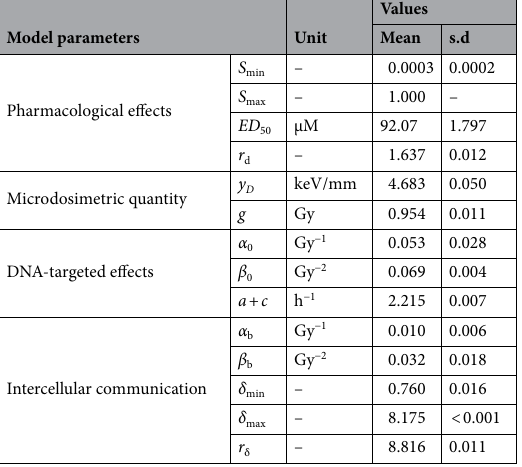
Table 1. Model parameters of the IMK model. These model parameters determined by fitting Eqs. (1)–(6) to the experimental survival (Fig. 2) by means of maximum likelihood method. The values were presented mean ± fitting error